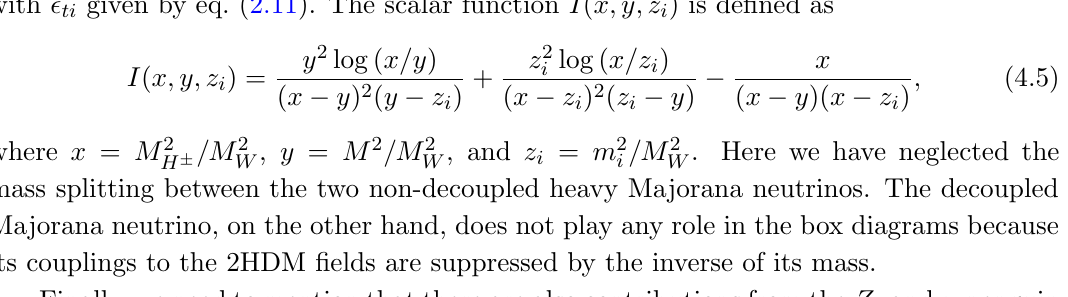
Figure 3 . Box diagrams contributing to b ! s(cid:22) + (cid:22) the LSS-I